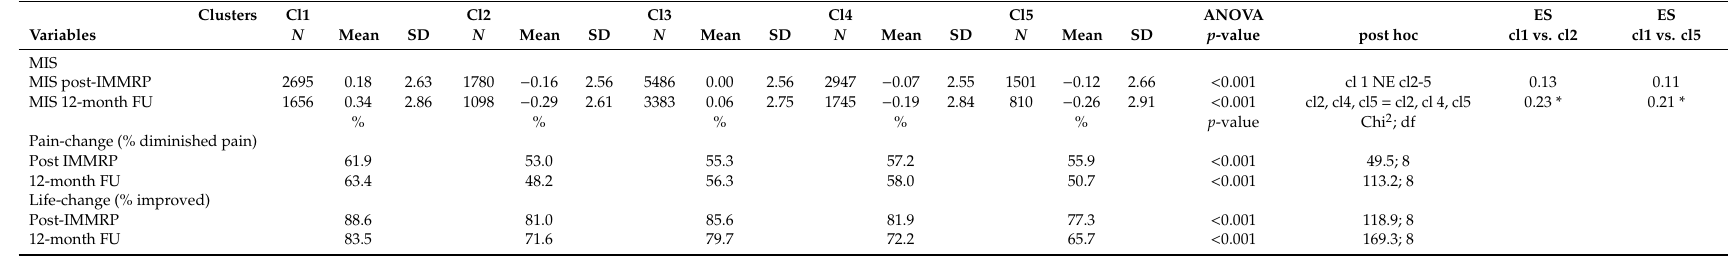
Table 9. Outcomes of IMMRP according to MIS and change variables (change-pain and change-life) in the five clusters post-IMMRP and at 12-month follow-up. Statistics are furthest to the right, i.e., group comparison (ANOVA and Chi 2 test). For MIS is also calculated pairwise e ff ect sizes (Hedges’g) for certain clusters.